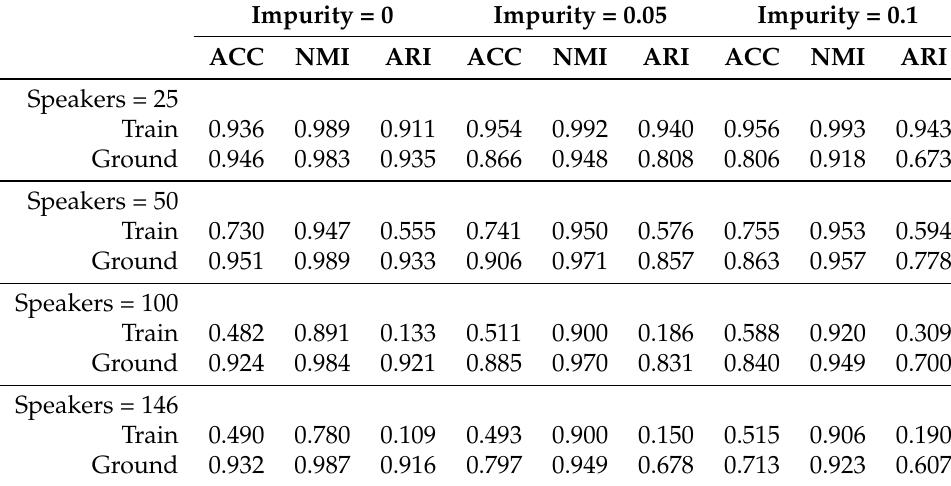
Table 4. The table benchmarks the pairwise architecture in LIBRI dataset with four groups of speakers, 25, 50, 100, and 150. For each group of speakers, the table also considers three segmentation impurities, 0, 0.05, and 0.1 to illustrate the shortcomings of incorrect segmentation, for fully unsupervised speaker recognition